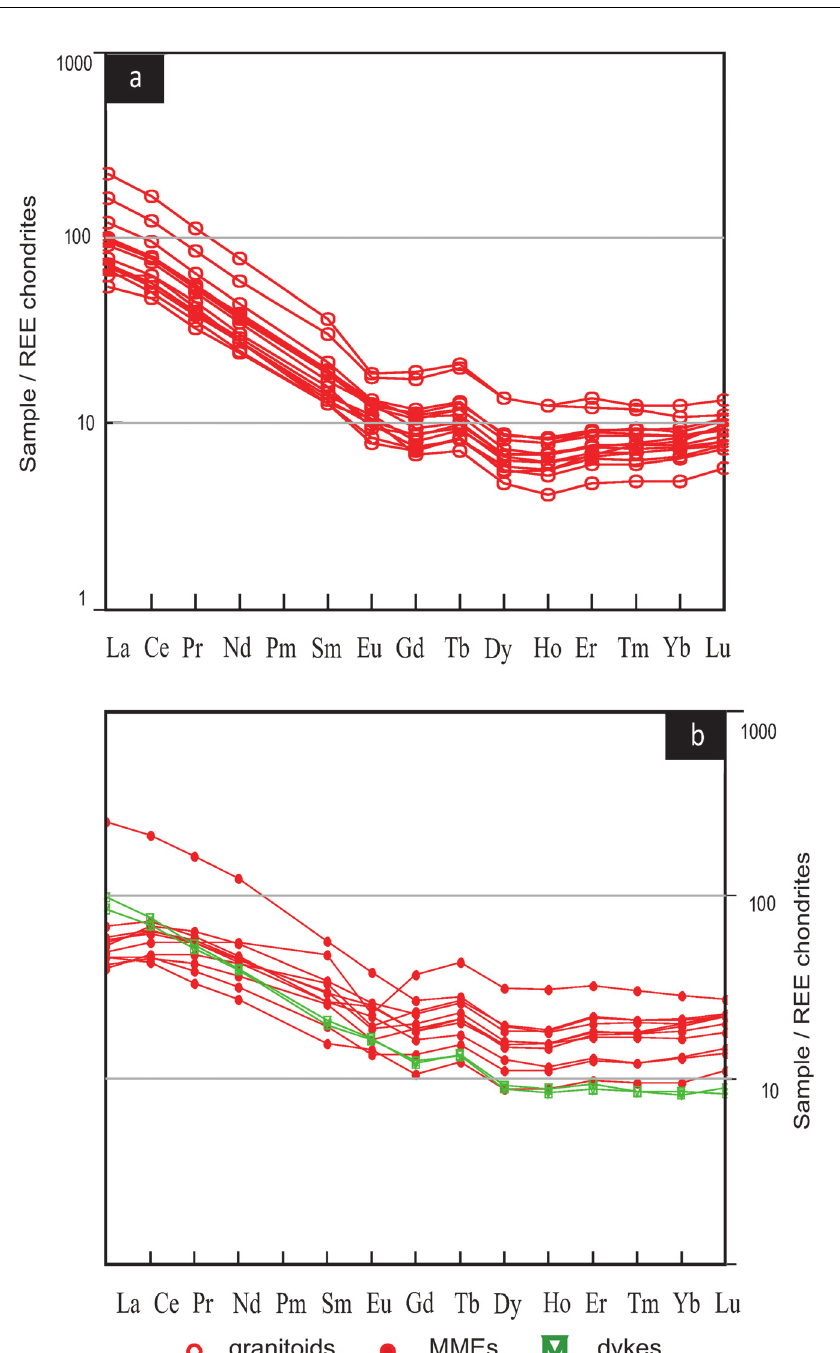
Fig. 7. Chondrite normalized rare-earth element patterns of the host rocks and their MMEs with dyke samples. Normalizing values are from Boynton